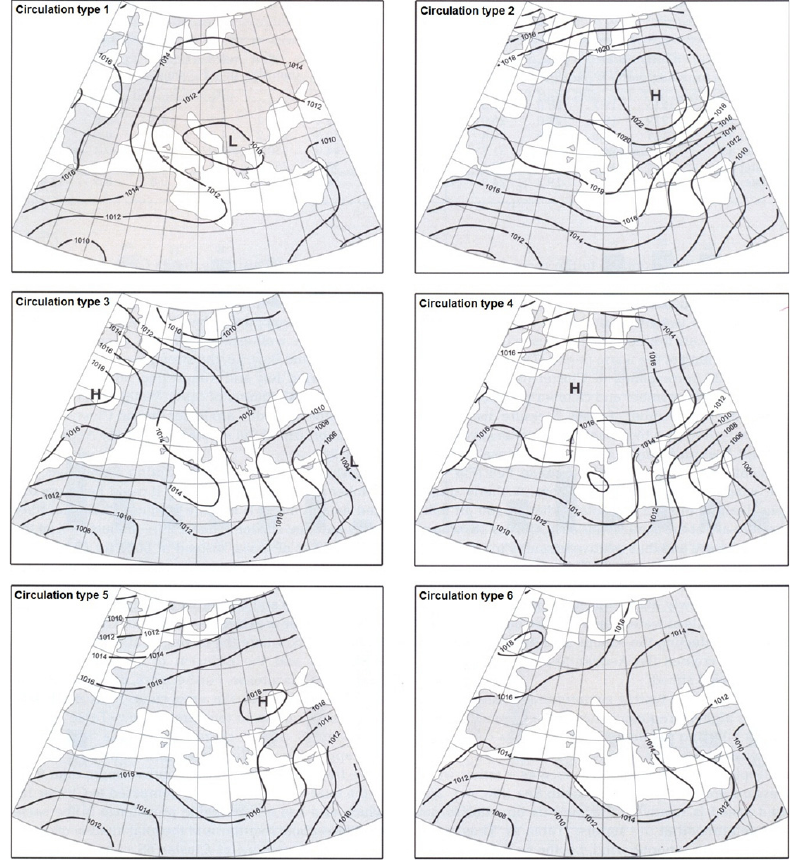
Fig. 7. The 6 circulation types over Europe, defined by Kassomenos et al. (2003) based on the Athens weather in the warm